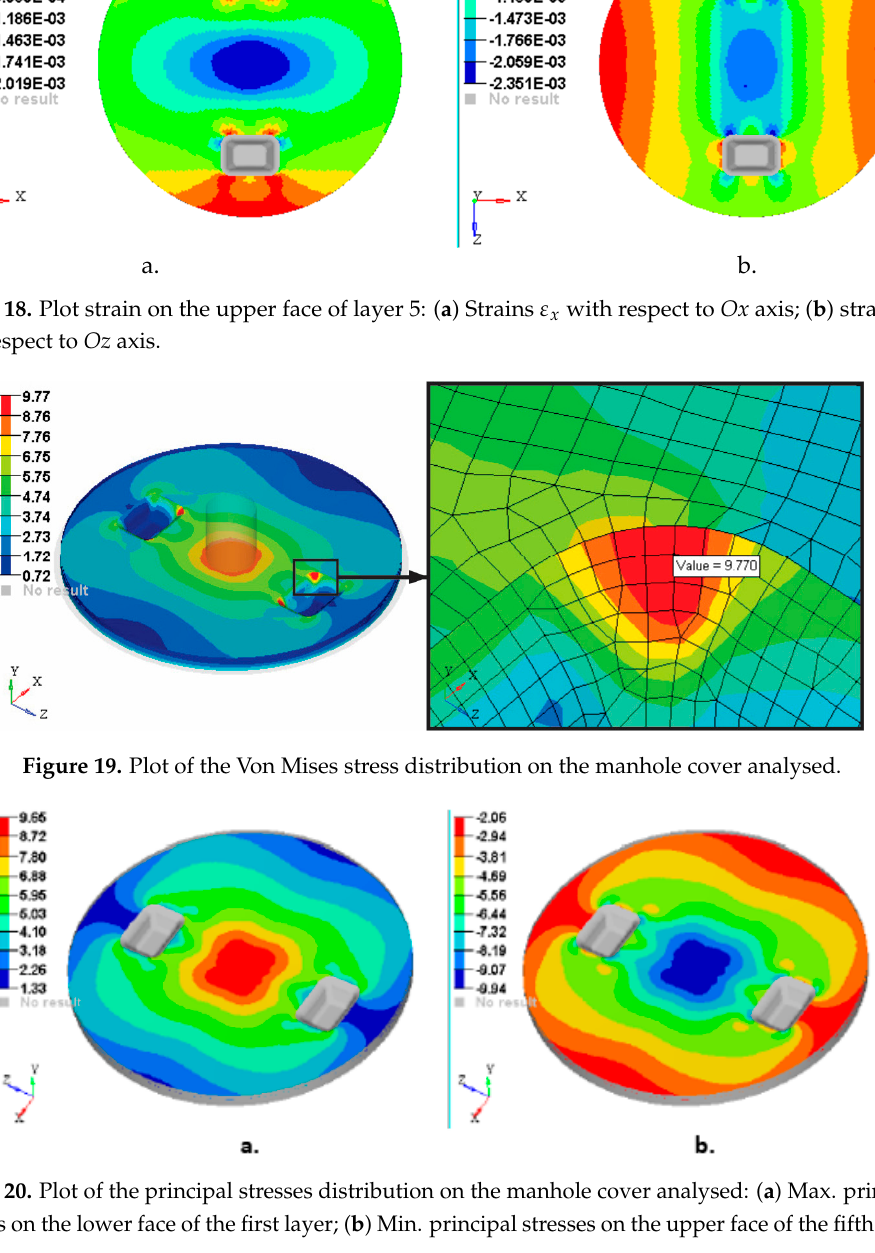
Figure 20. Plot of the principal stresses distribution on the manhole cover analysed: ( a ) Max. principal stresses on the lower face of the first layer; ( b ) Min. principal stresses on the upper face of the fifth layer.